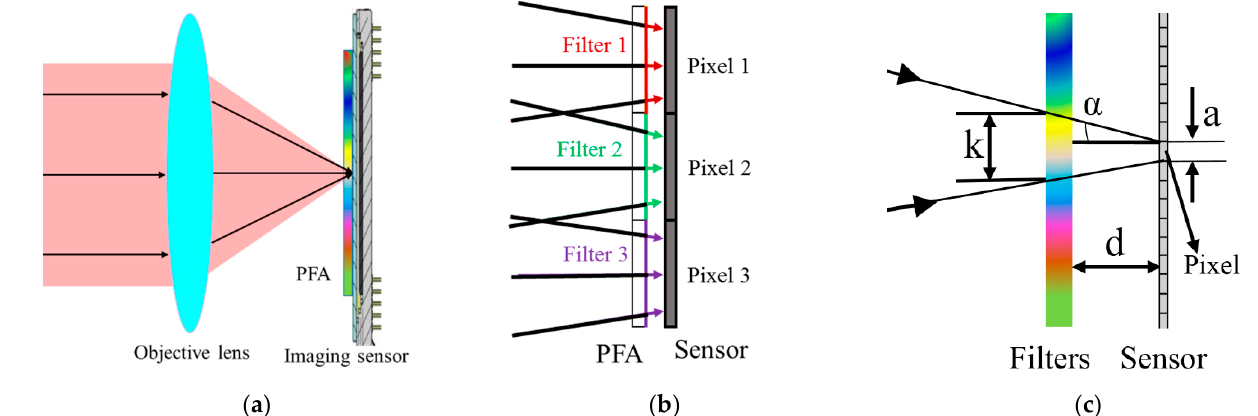
Figure 2. Once-imaging scheme: ( a ) Optical structure, ( b ) the correspondence between filters and pixels, and the ( c ) generation of crosstalk.